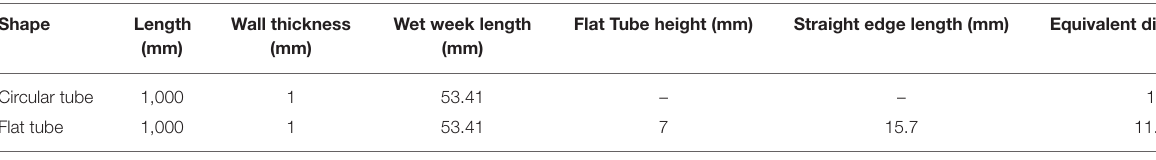
TABLE 1 | Geometrical parameters of heat transfer tube.